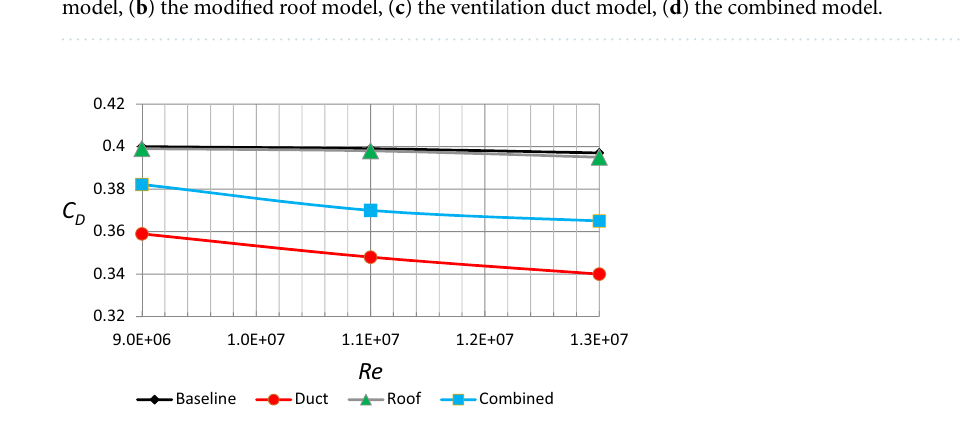
Figure 19. Drag coefficient as a function of Reynolds number for different configurations of Discovery